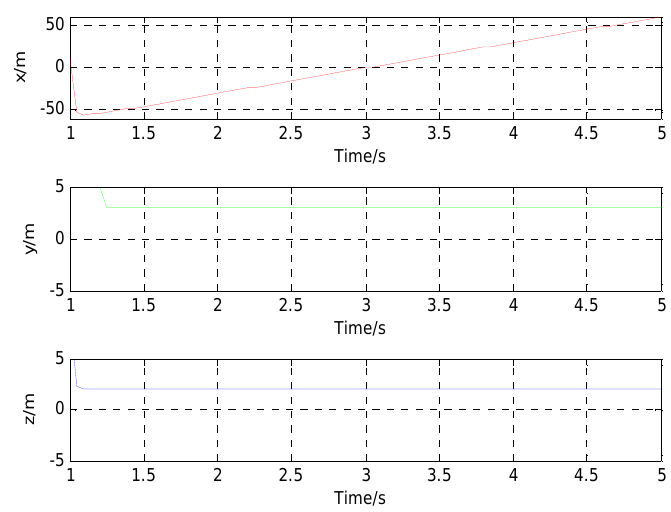
Figure 6. Simulation location results.